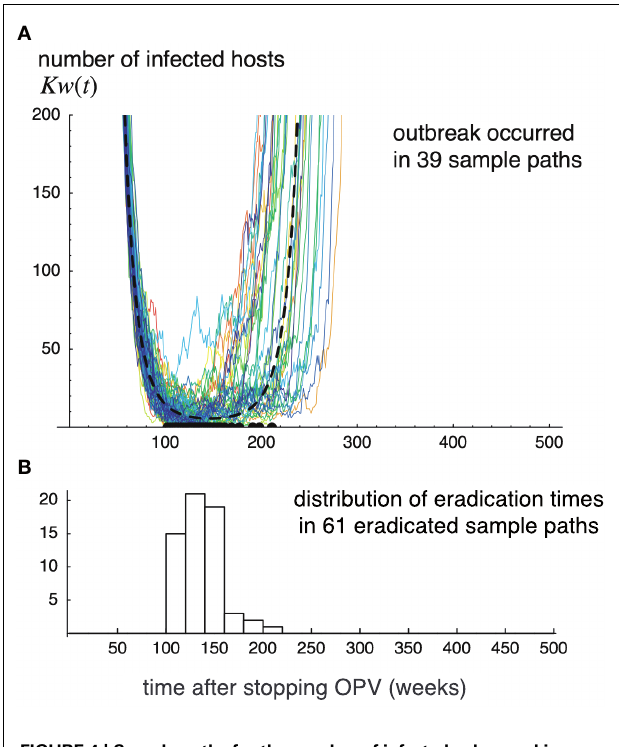
FIGURE 4 | Sample paths for the number of infecteds observed in Monte Carlo simulations. Sample paths for the number of infecteds observed in Monte Carlo simulations of the stochastic process corresponding to dynamics (7). One hundred independent runs are illustrated by thin lines.Thick broken lines indicate the deterministic trajectory (A) .The histogram shows the distribution for the times at which viruses went to extinction (B) . 38 out of 100 runs never go to extinction, and cause outbreaks.The parameters are the same as in Figure 3 , and K = 10 8